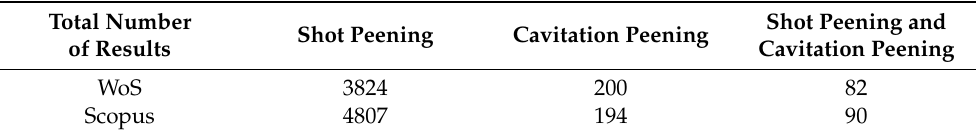
Table 1. Search results for the phrases: cavitation peening (CP), shot peening (SP), and cavitation peening plus shot peening (CP + SP). Total Number Shot Peening Cavitation of Results